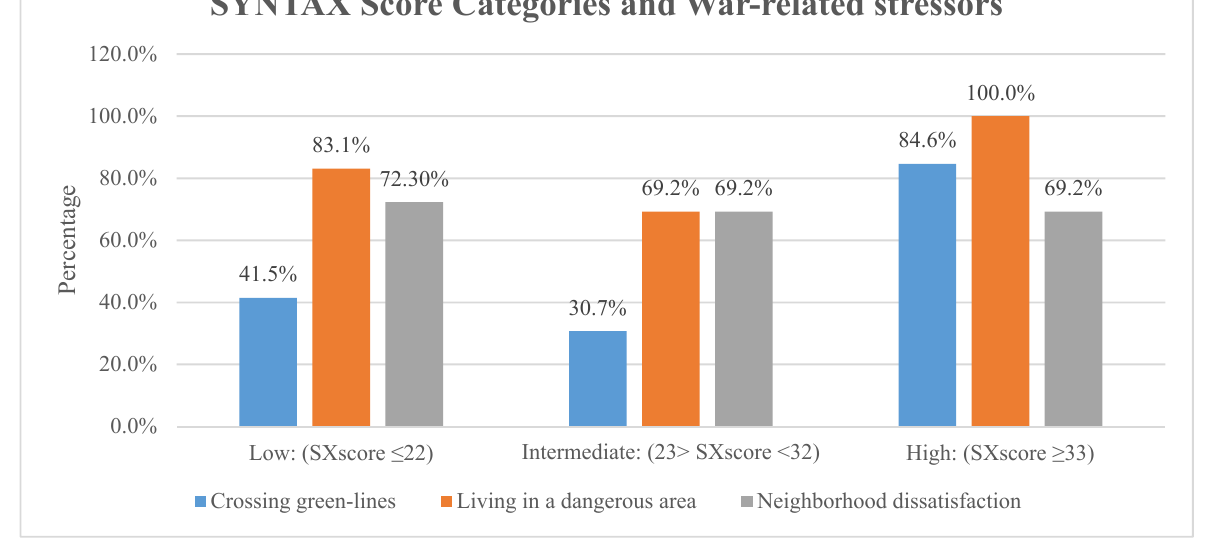
Figure 2. Percentage of war-related stressors within each SX score category. Chi-square testing shows a significant association between only crossing green-lines and SX score categories. Crossing green-lines ( p < 0.01), living in a dangerous area ( p = 0.11), and neighborhood dissatisfaction ( p = 0.96).